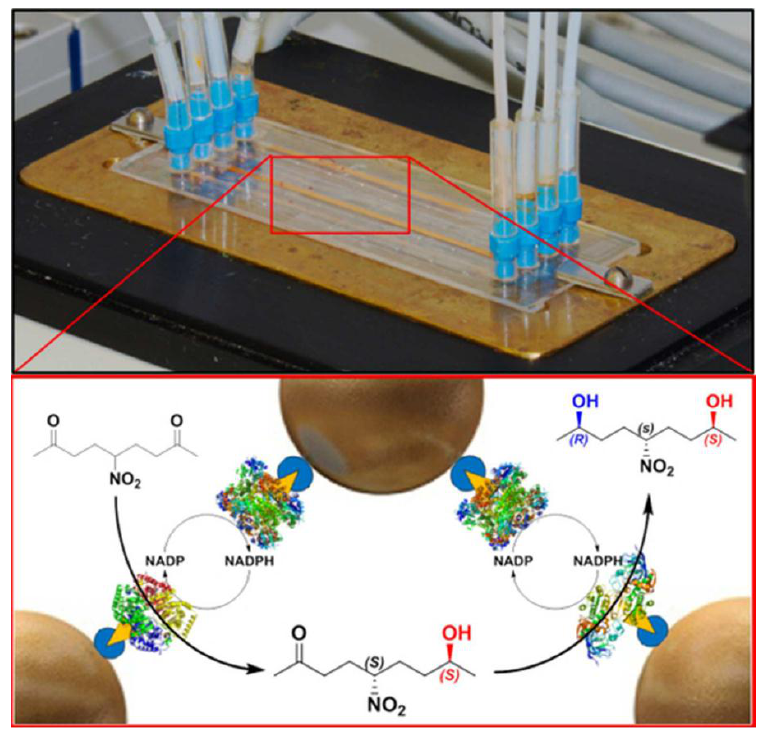
Figure 2. Compartmentalized microreactor with multiple enzymes. Reproduced with permission from Peschke et al.; self-immobilizing fusion enzymes for compartmentalized biocatalysis, published by the American Chemical Society, 2017.